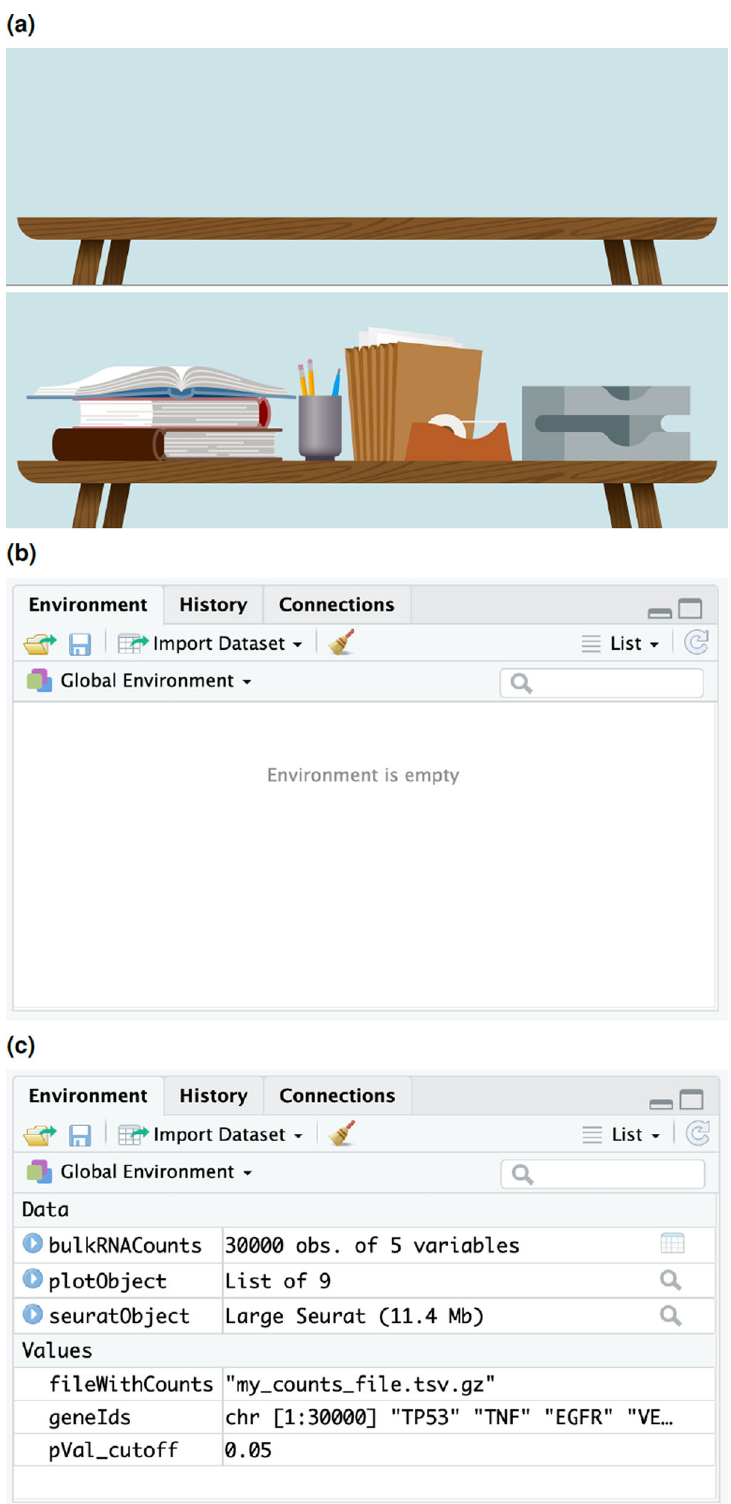
Figure 2. R environment has a physical analogue. (a,b) An empty R environment is analogous to an empty desk at the start of analysis. (a,c) As analysis progresses, objects with data are stored in the current